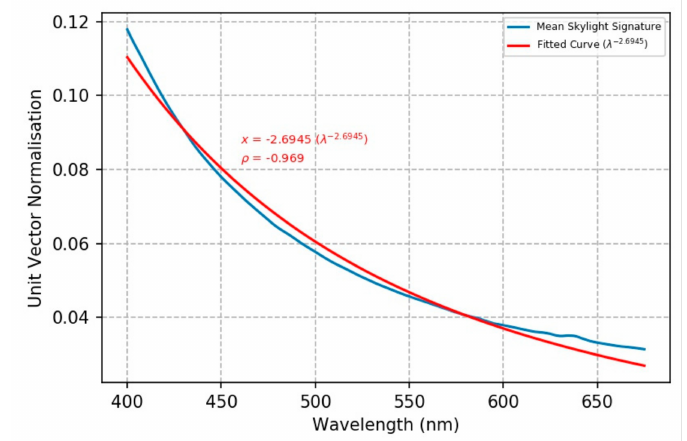
Figure 13. Non-linear least squares fitting for the relative scattering model λ − x to the mean spectral signature of the sky has an Angstrom-law exponent (x) of − 2.6945. Pearson correlation coe ffi cient p = −